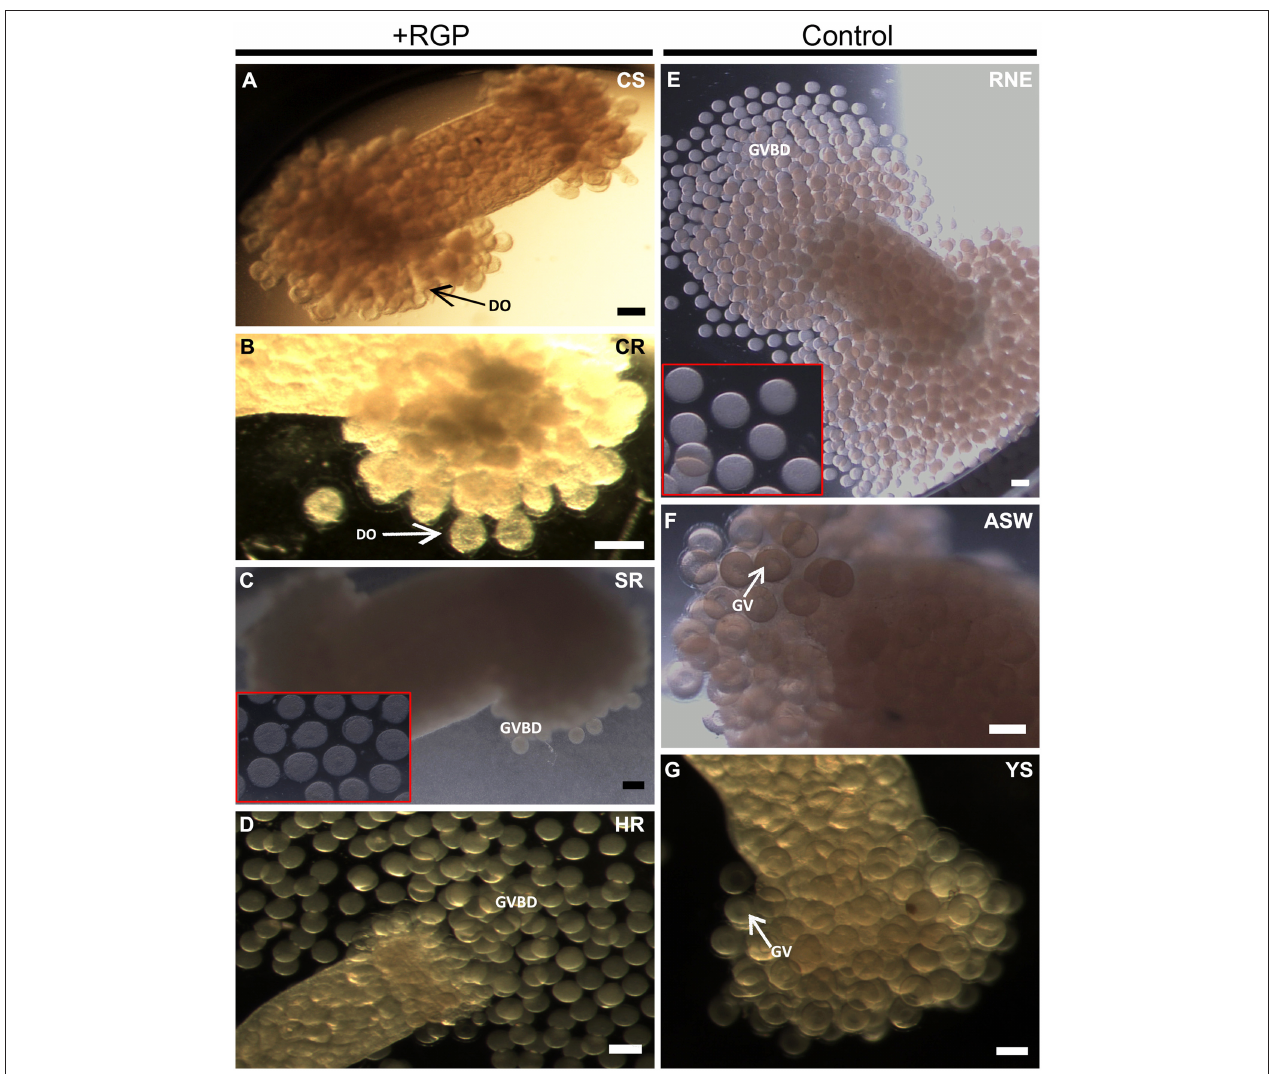
FIGURE 4 | Holothuria scabra oocyte maturation bioassay with recombinant RGP. Ovarian segments were incubated for 3h in (A) crude supernatant, CS; (B) crude concentrated RGP, CR; (C) SepPak-purified RGP, SR; inset shows higher magnification of mature oocytes from ovarian segment incubated in 96 µ g/ µ L SR; (D) His and Amicon-purified RGP, HR; (E) yeast solution without RGP, YS; (F) filtered artificial sea water, FASW; and (G) radial nerve extract, RNE. Two insets (red boxes) indicate higher magnification of mature oocytes inside ovarian segment incubated in SR (96 µ g/ µ L) and RNE after 3h. DO indicates the distorted oocyte; GV, germinal vesicle; GVBD, germinal vesicle breakdown. All scale bars indicate 200 µ